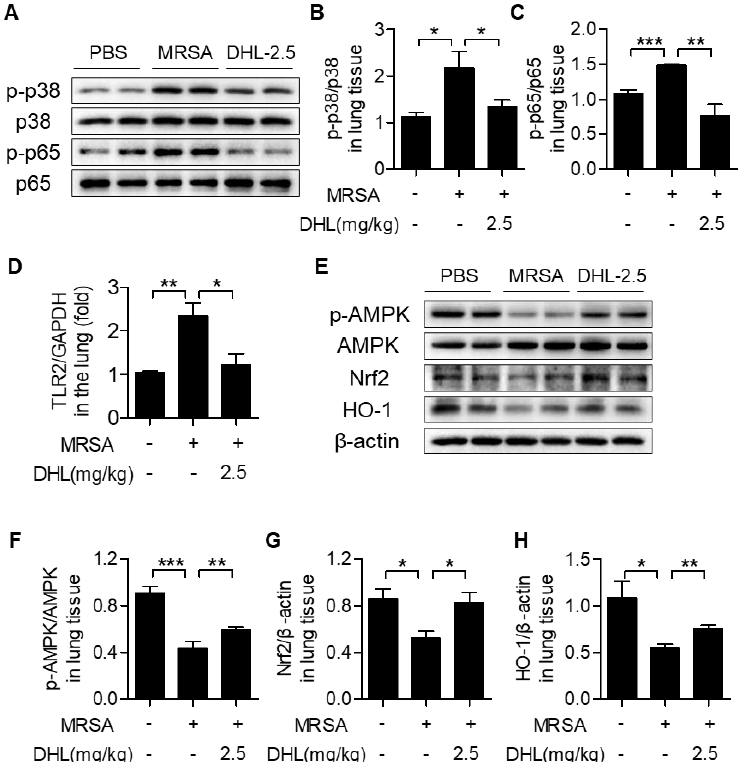
Figure 6. DHL inhibits the TLR2-mediated phosphorylation of p38 MAPK and NF- κ B, but promotes the activation of the AMPK/Nrf2 pathway in an MRSA-induced ALI model. Mice were subjected to an intratracheal injection of MRSA (4 × 10 7 CFU/mouse), and subsequent intraperitoneal injection of vehicle or DHL (2.5 mg/kg) for 24 h. The lung tissues were collected for further analysis. ( A ) The phosphorylation of p38 MAPK and p65 of mouse lung tissues was measured by Western blot; the ratios of p-p38/p38 ( B ) and p-p65/p65 ( C ) were semiquantitatively analyzed using ImageJ software. ( D ) The mRNA level of TLR2 in mouse lung tissues was tested by real-time PCR. ( E ) The phosphorylation of AMPK and the total protein contents of Nrf2 and HO-1 in mouse lung tissues were detected by Western blot; β-actin was used as the loading control. The ratios of p-AMPK/AMPK ( F ), Nrf2/β-actin ( G ), and HO-1/β-actin ( H ) were analyzed by ImageJ software. n = 5, * p < 0.05, ** p < 0.01, *** p < 0.001.